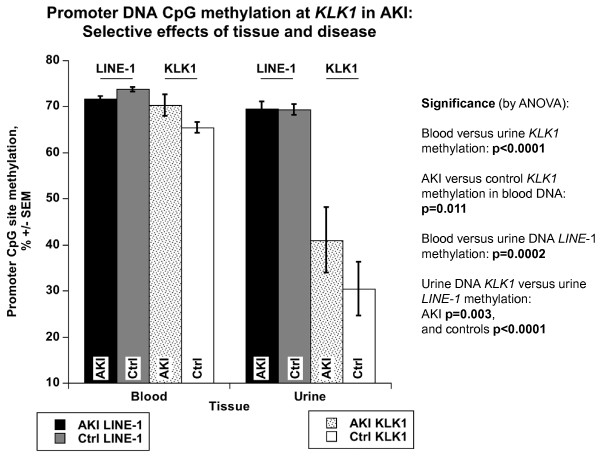
CpG methylation analyzed by bisulfite sequencing: Results at the KLK1 promoter, as well as a global control (LINE-1 repetitive elements), in genomic DNA from urine or blood (mononuclear cells). Results (shown as mean ± one SEM), from established AKI cases or healthy controls, were analyzed by ANOVA, factoring for age, sex and race. LINE-1 reagents (Pyromark, Biotage) were used to analyze the 3 CpG sites in LINE-1 repetitive elements, while the KLK1 gene was analyzed by a separate PCR covering 4 promoter CpGs. Promoter KLK1 specific methylation was substantially higher in blood than urine DNA (blood 66.38 ± 1.00 vs. urine 33.43 ± 4.67%; ANOVA p < 0.0001). Promoter KLK1 methylation in blood DNA was higher in AKI than controls (AKI, 70.32 ± 2.27 vs. controls, 65.36 ± 1.05%; ANOVA p = 0.011). Promoter KLK1 methylation in urine DNA did not differ in AKI versus controls (AKI, 40.95 ± 7.06 vs. controls, 30.35 ± 5.88%; ANOVA p = 0.22). Global LINE-1 methylation was greater in both blood than urine DNA (blood 73.11 ± 0.38 vs. urine 69.37 ± 0.86%, p = 0.0002). LINE-1 methylation in blood DNA did not differ in AKI and controls (AKI, 71.71 ± 0.44 vs. controls, 73.67 ± 0.41%; ANOVA p = 0.08). LINE-1 methylation in urine DNA did not differ in cases/controls (AKI, 69.53 ± 1.54 vs. controls, 69.29 ± 1.05%; ANOVA p = 0.79).